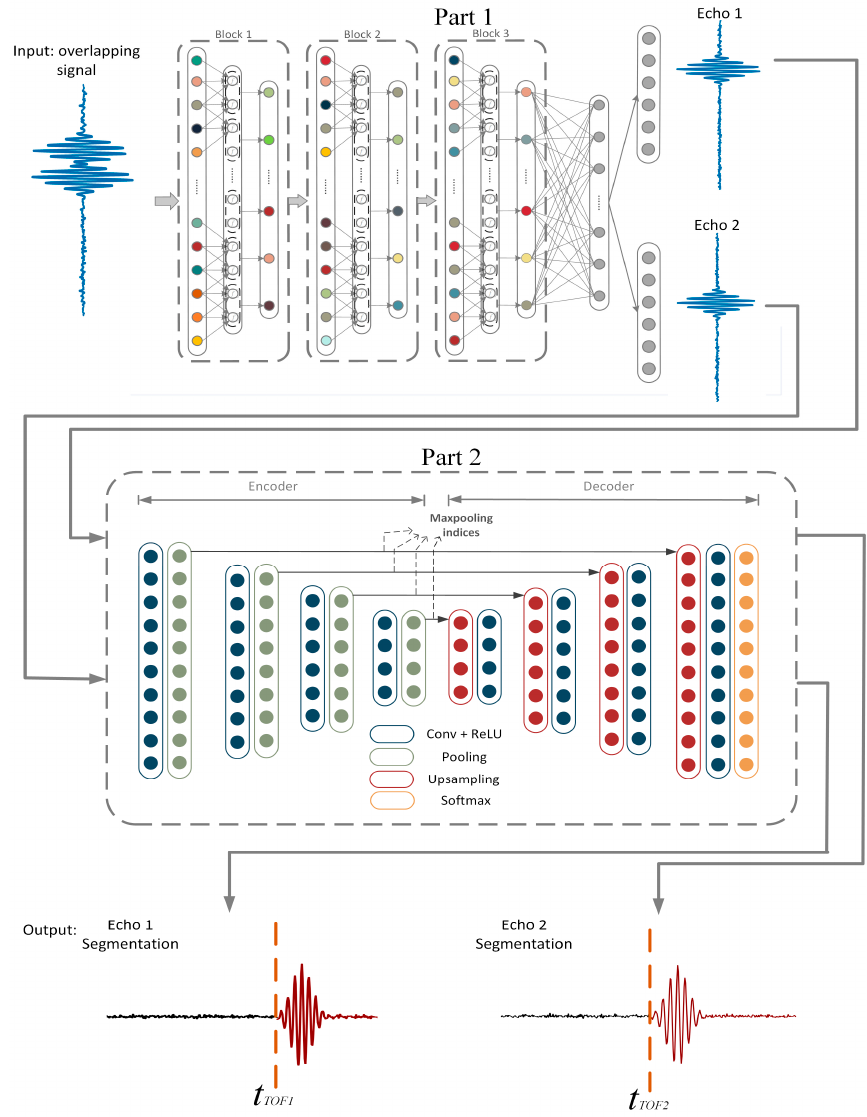
Figure 3. An illustration of the WT-net architecture including Part 1, S-net, and Part 2, D-net. S-net is based on 1D-CNN, which utilizes trainable filter kernels to extract the potential features in